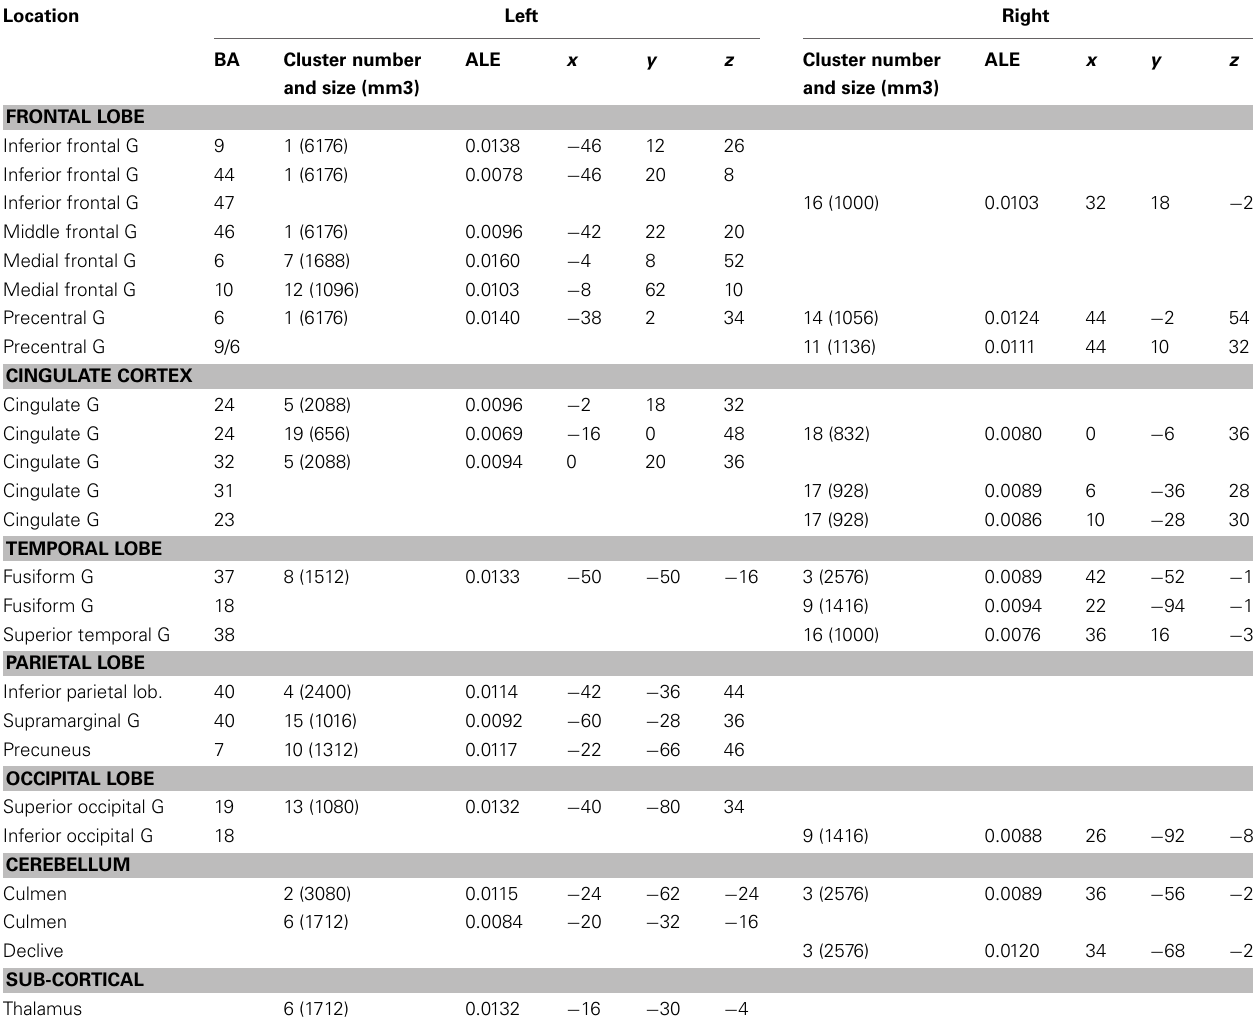
Table 4 | Locations of clusters with significant ALE values for unusual generation tasks.